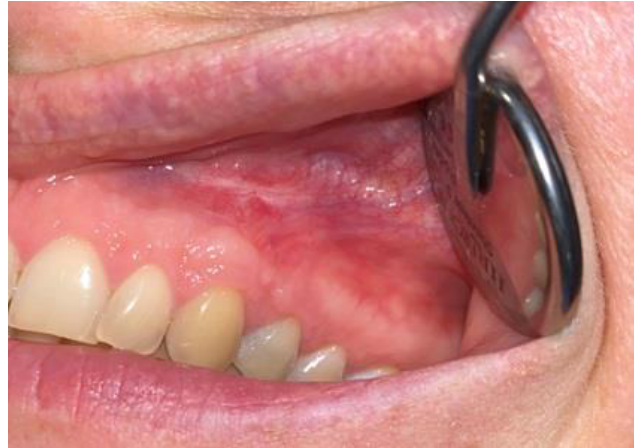
Figure 11. Intraoral photograph 15 months after surgery.